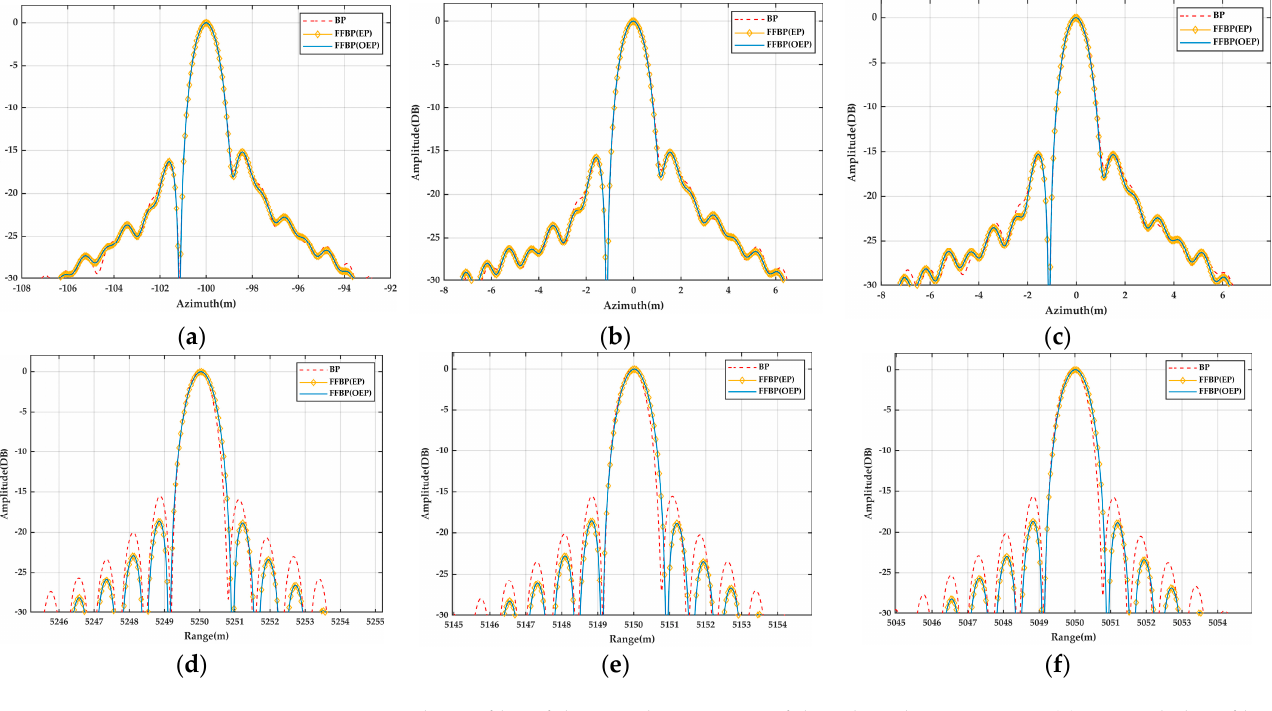
Figure 12. The profiles of the impulse response of the selected point targets. ( a ) Azimuthal profile of the target A; ( b ) Range profile of the target A; ( c ) Azimuthal profile of the target B; ( d ) Range profile of the target B; ( e ) Azimuthal profile of the target C; ( f ) Range profile of the target C.